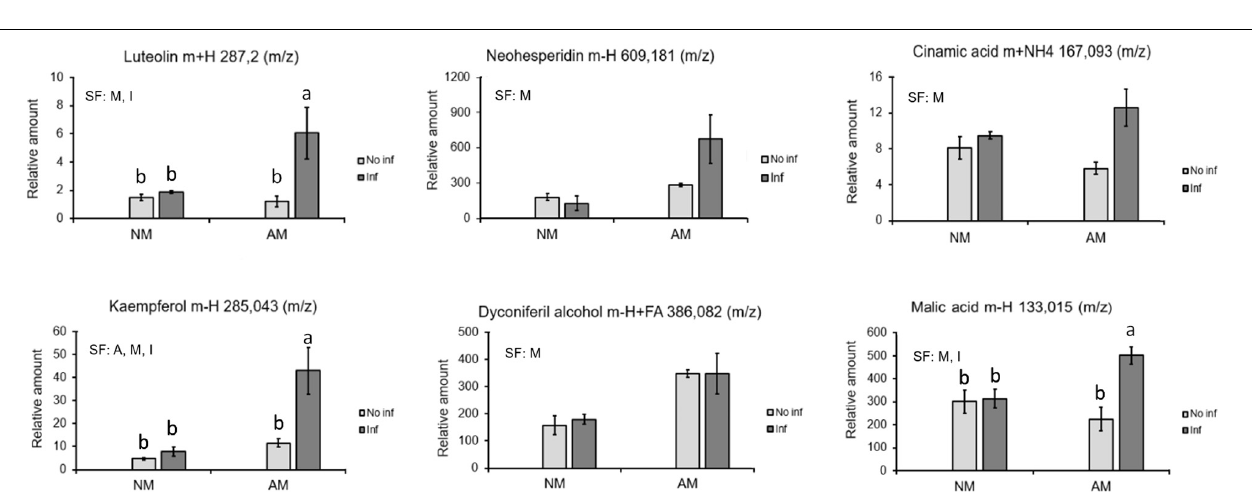
FIGURE 6 | Heatmap analysis of locally infested C. aurantium leaves. Results from mycorrhizal and non-mycorrhizal non-infested C. aurantium plants or plants previously infested with T. urticae at (A) 24 h or (B) 48 h post infestation. Four different treatments were employed in both cases: NM: non-mycorrhizal SO plants. AM: mycorrhizal SO non-infested plants. NM inf: non-mycorrhizal infested plants. AM inf: mycorrhizal infested plants. Heatmaps were obtained by the software MarVis (Marvis Cluster). Signals of different treatments were compared after a Kruskal–Wallis test ( P < 0.05) following adduct and isotope correction. A pool from 6 individual plants was employed for each combination. Three independent and two technical replicates were randomly performed.